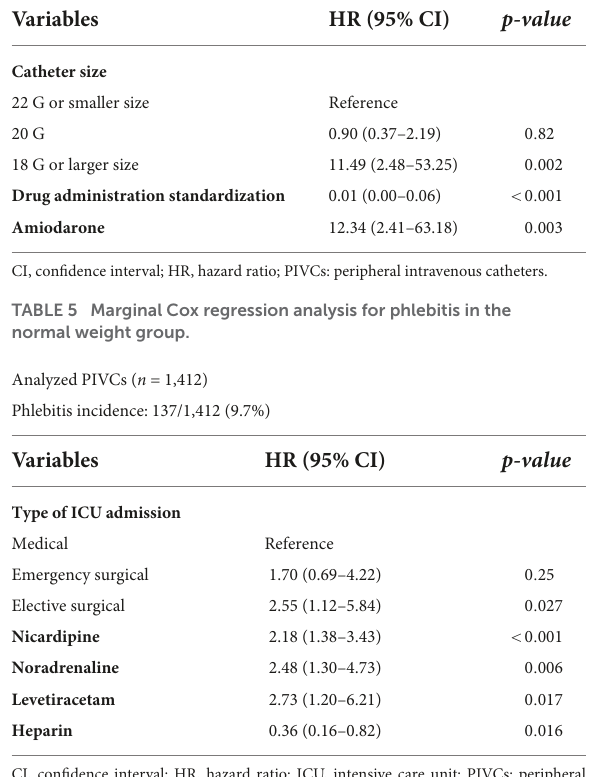
TABLE 6 Marginal Cox regression analysis for phlebitis in the overweight/obese group.